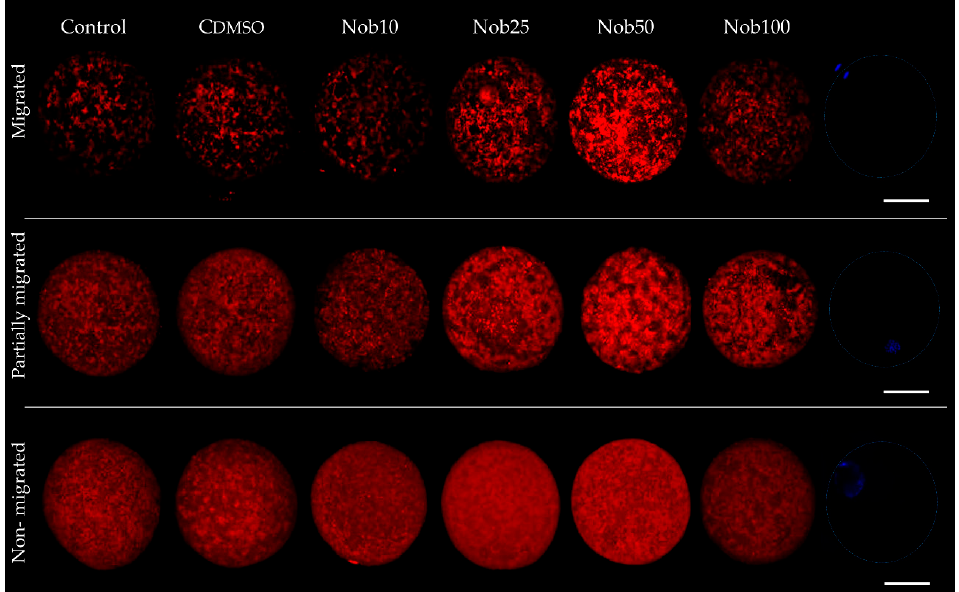
Figure 2. Representative fluorescent images of mitochondria migration pattern in bovine oocytes after in vitro maturation in the presence of nobiletin. Control: oocytes cultured in the presence of synthetic oviductal fluid (SOF) and 5% fetal calf serum (FCS); C DMSO : oocytes cultured in the presence of SOF + 5% FCS supplemented with 0.01% DMSO; Nob10, Nob25, Nob50, Nob100 oocytes cultured in presence of SOF + 5% FCS supplemented with 10, 25, 50 and 100 μ M nobiletin, respectively. Scale bar 50 μ m.